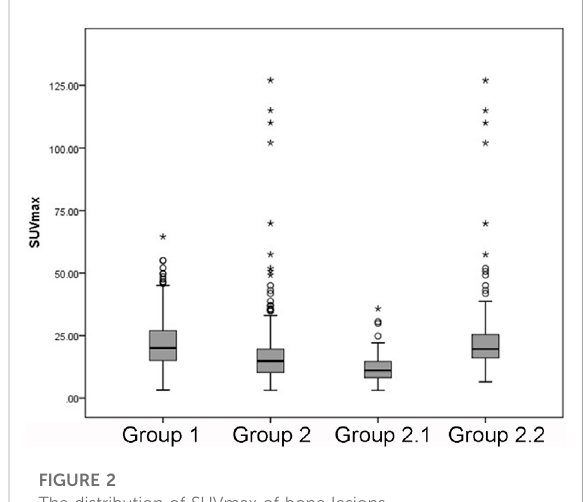
FIGURE 2 The distribution of SUVmax of bone